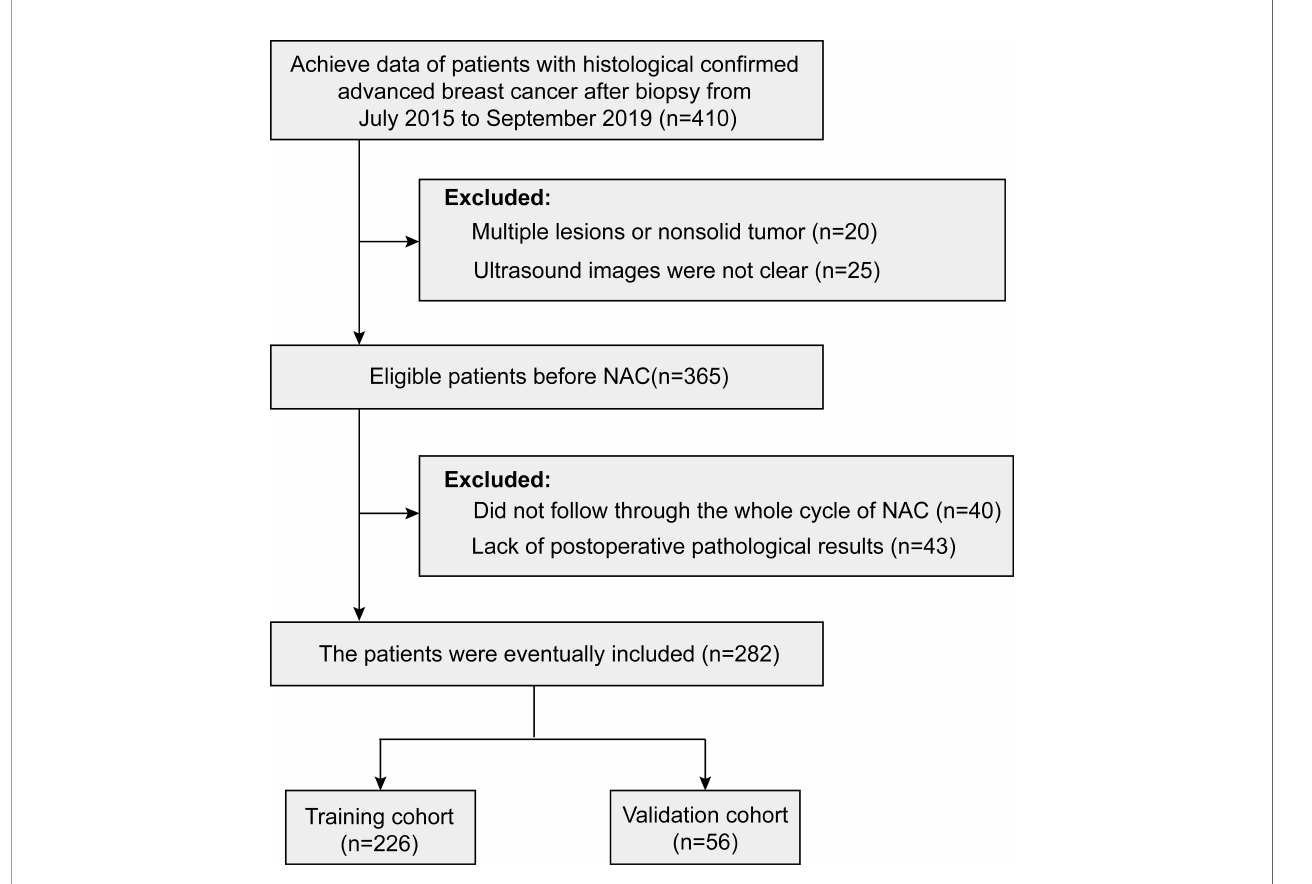
FIGURE 1 | Recruitment pathway for patient